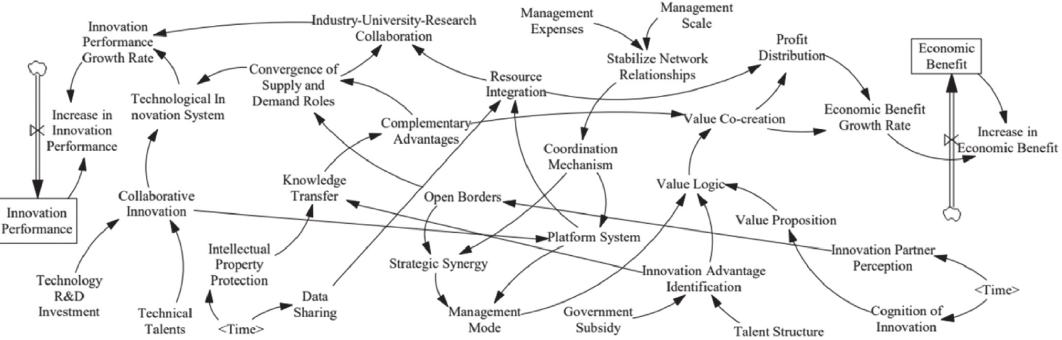
Figure 3: System flow Table 3: List of model variables.